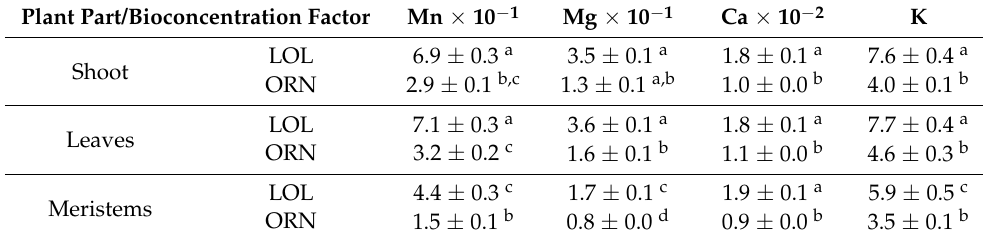
Table 2. Bioconcentration factors of Mn, Mg, Ca, and K for shoots, leaves, and meristems of wheat grown for 3 weeks in acidic soil after the previous development of Lolium rigidum (LOL) or Ornithopus compressus (ORN). Different letters indicate statistically significant differences ( p < 0.05) on the basis of Tukey’s test for each element.